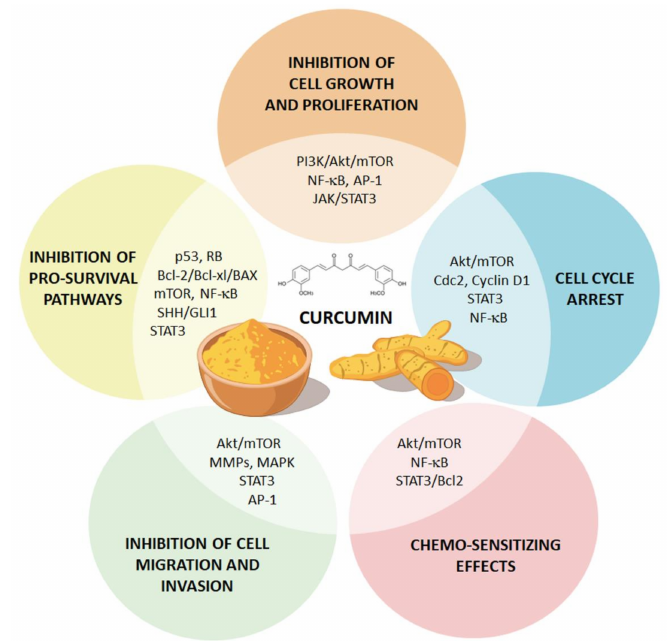
Figure 1. Curcumin modulates major glioblastoma multiforme (GBM)-associated signaling pathways. The cartoon summarizes the major e ff ects of curcumin on GBM cells. In fact, curcumin was shown to broadly a ff ect core-signaling pathways of GBM neurobiology. For instance, curcumin suppresses tumor growth by inhibiting tumor-promoting pathways (i.e., nuclear factor κ B (NF-kB),